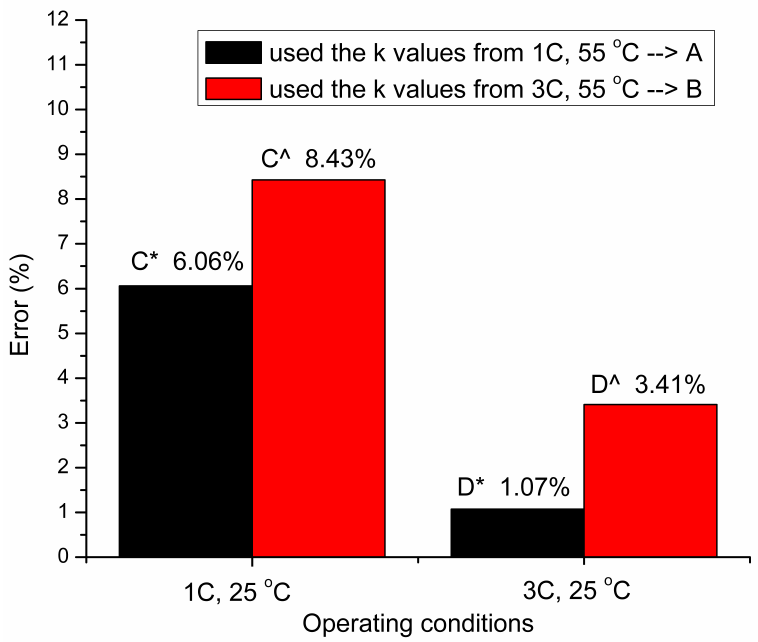
Figure 7. Estimate % error using k’s values from 55 ◦ C.